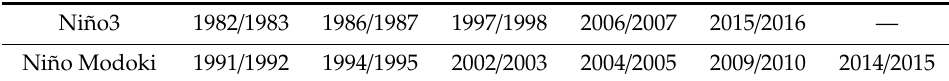
Table 2. El Niño3 and El Niño Modoki years over the period (1979–2016) used to compute the composite maps.